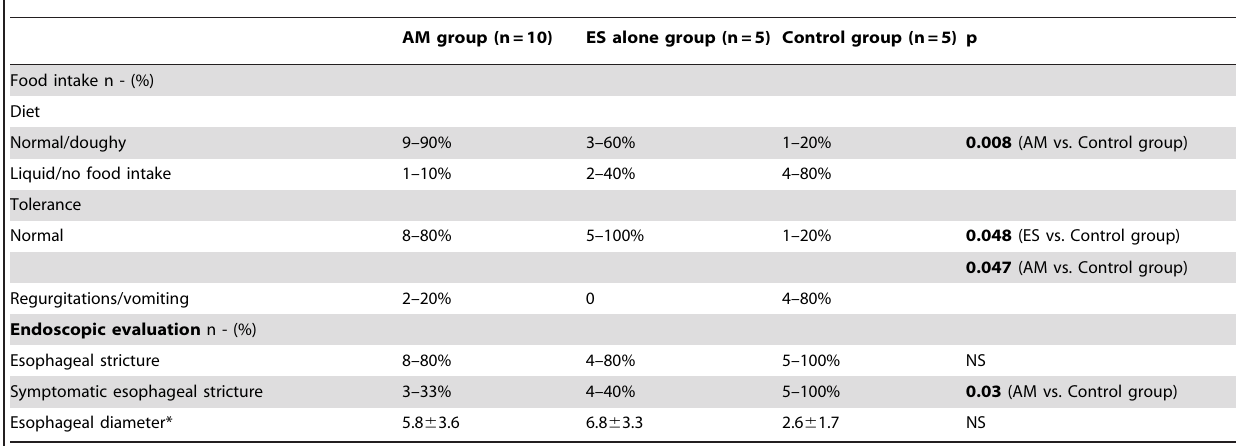
Table 1. Clinical and endoscopic evaluation on the 14 th postoperative day.